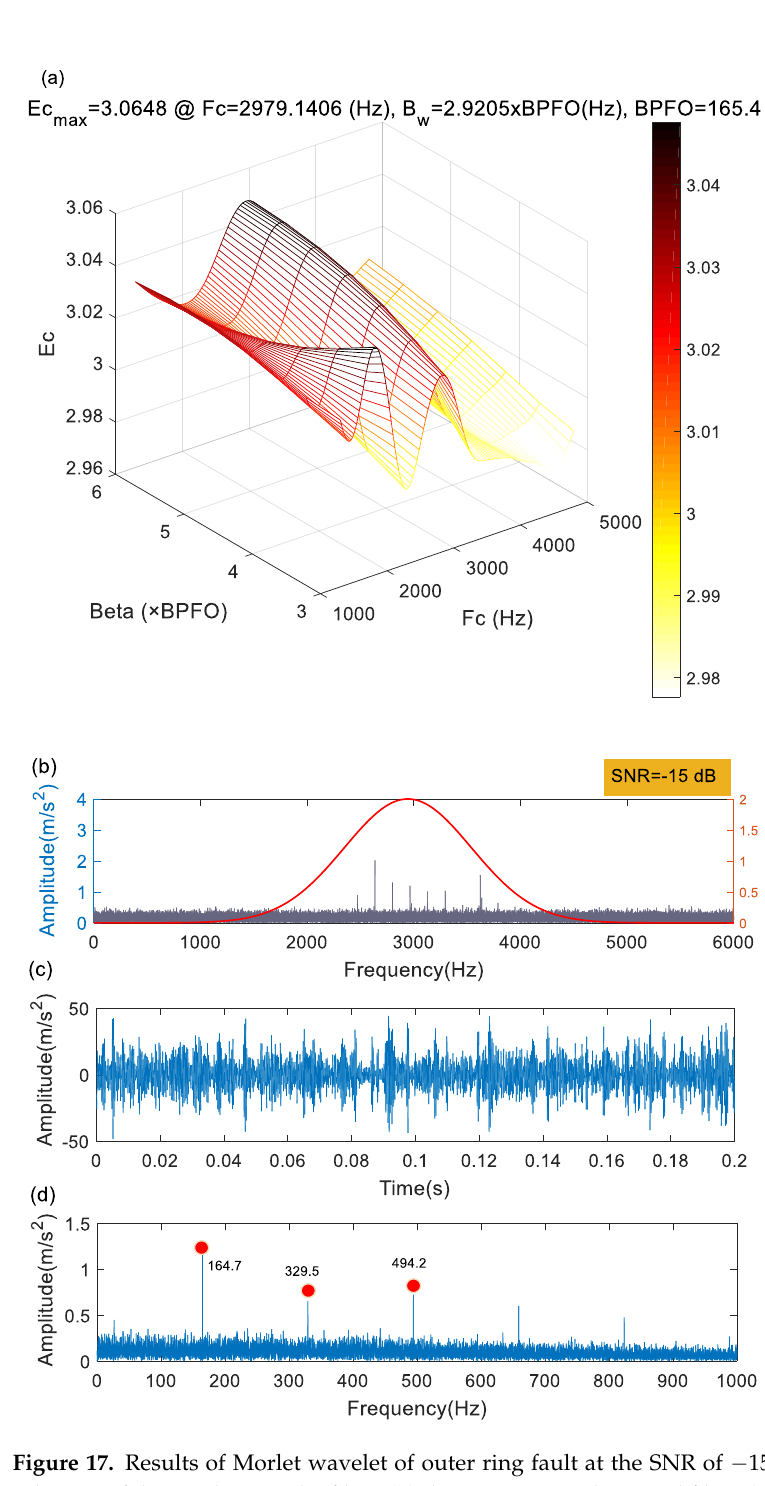
Figure 17. Results of Morlet wavelet of outer ring fault at the SNR of −15 dB: ( a ) the parameter selection of the Morlet wavelet filter; ( b ) the spectrum and optimal filter; ( c ) filtered signal; ( d ) the envelope spectrum of the filtered signal.